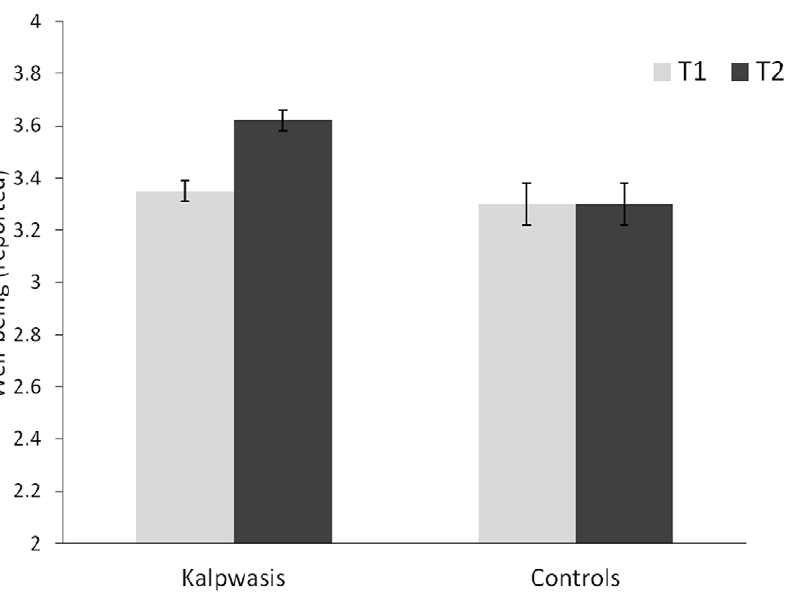
Figure 2. Well-being amongst Kalpwasis and Controls at T1 and T2. Estimated Marginal Means and Standard Errors. doi:10.1371/journal.pone.0047291.g002 Figure 3. Decomposing this interaction shows that whereas there was no difference between the two groups at T1 (Kalpwasis EMM = 2.04, SE= .04; Controls EMM = 2.16, SE = .07), F (1, 533) = 2.03, p = .16, g p2 = .004, at T2 Kalpwasis reported signif- icantly fewer symptoms ( EMM= 1.66, SD = .04) than Controls ( EMM = 1.96, SE = .07), F (1, 533)= 15.02, p , .001, g p2 = .027. Moreover, for the Kalpwasis there was a sharper decrease in their reporting of symptoms from T1 ( EMM = 2.04, SE =.04) to T2 ( EMM = 1.66, SE = .04), F (1, 415)= 88.35, p , .001, g p2 = .176, than amongst the Controls (T1 EMM = 2.16, SE =.07; T2 EMM =1.96, SE = .07), F (1, 126) = 6.67, p = .011, g p2 = .05.